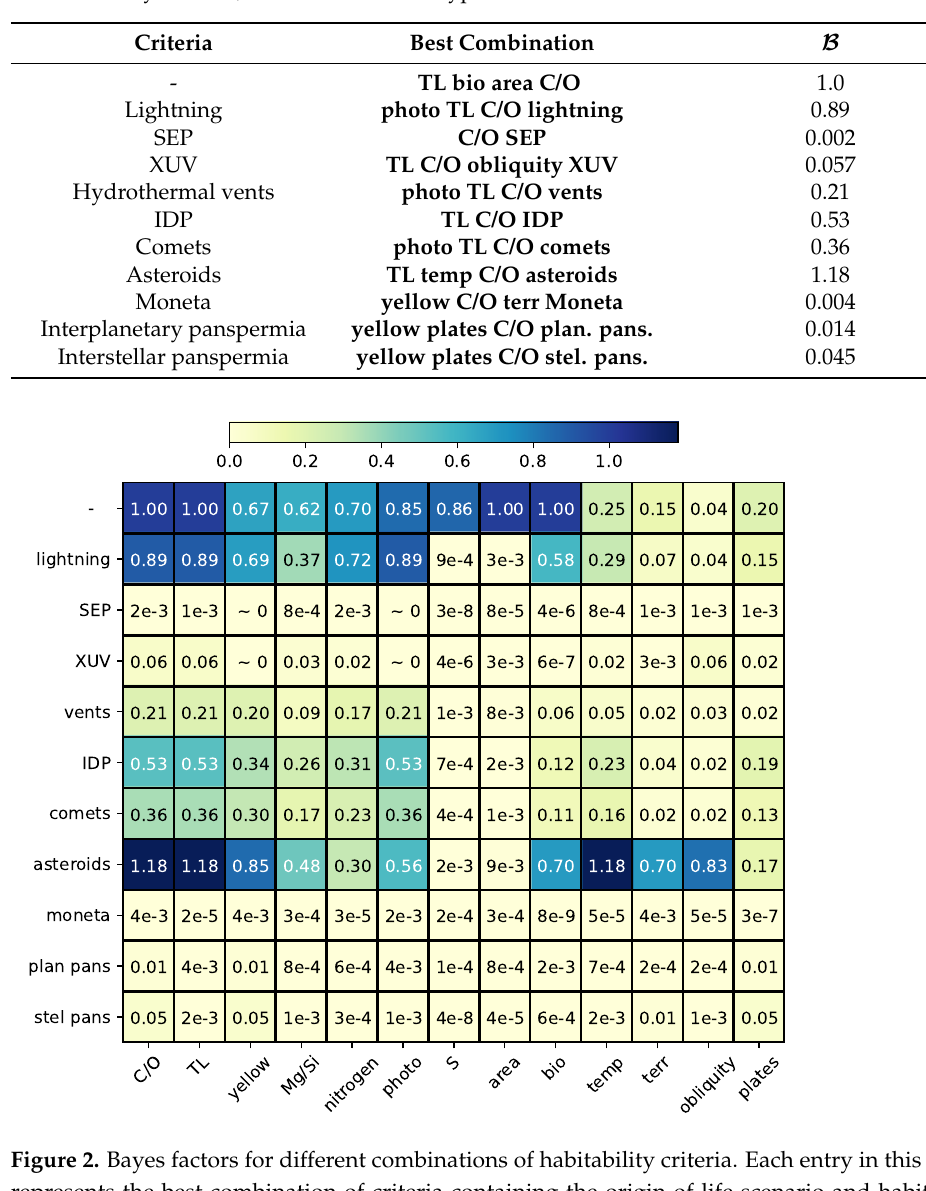
Table 2. Best combinations of habitability criteria for each origin of life scenario, along with their associated Bayes factor, relative to the null hypothesis.